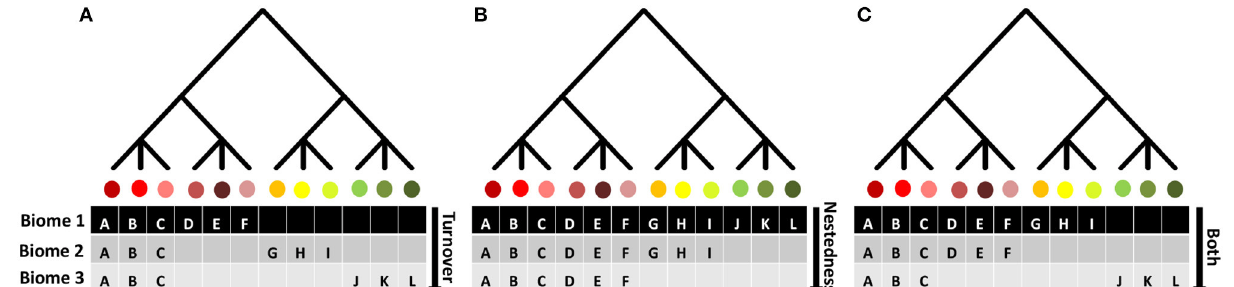
Figure 1 | Conceptual framework for a partition procedure of beta diversity into nestedness and turnover components. Turnover is the difference between two assemblages due to contrasting subsets of species or lineages from a source pool, potentially caused by environmental sorting processes or speciation processes associated with endemism forced by topographic barriers, while nestedness is the difference in species composition between two assemblages due to attrition of species in one assemblage relative to the other. The example involves the three dimensions considered in our study and three biomes. Also, as species carry both functional and phylogenetic information (Safi et al., 2011; Swenson, 2011), it is likely that observed patterns of nestedness and turnover will be equivalent for the three dimensions. (A) All biomes have the same number of species and display a pattern of species turnover within and between biomes. (B) Shows complete nestedness (differences in diversity between biomes), where biomes 2 to 3 represent a subset of more diverse biomes (biome 1), potentially as a response to environmental filters. (C) Shows the joint contribution of both components to the patterns of beta diversity.